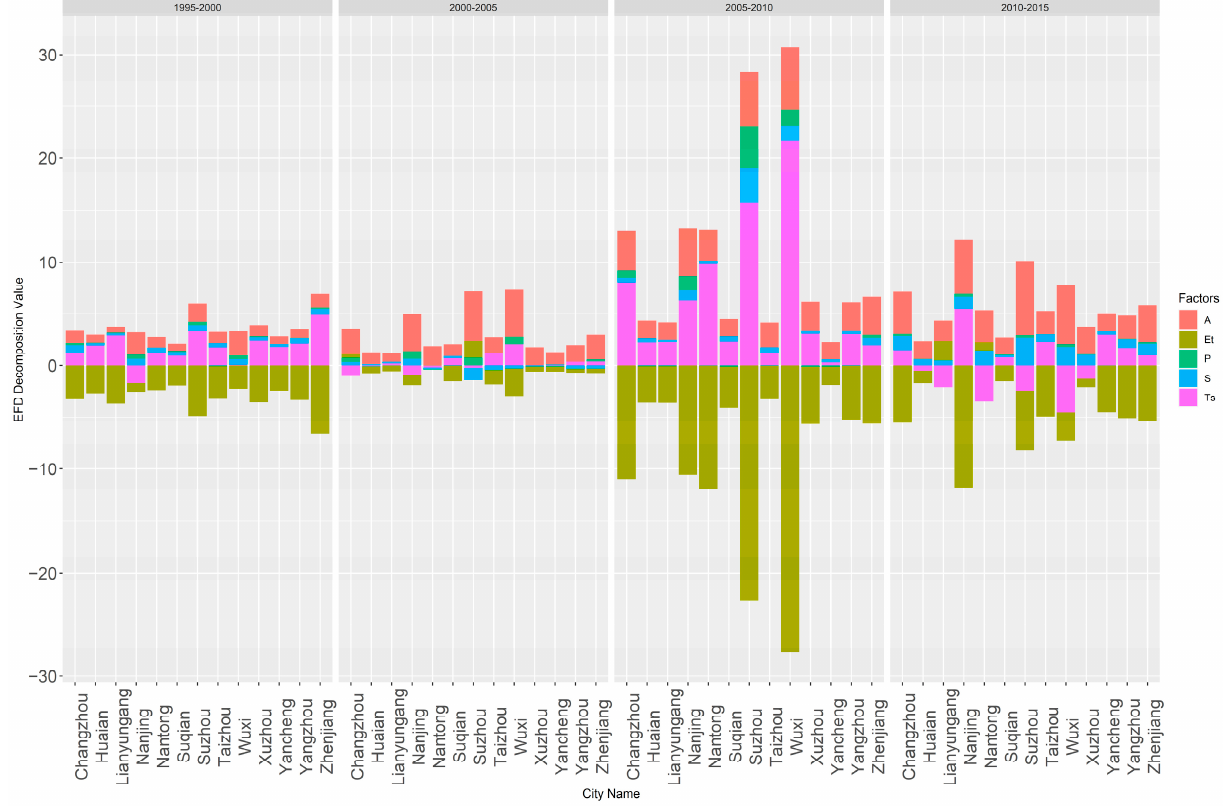
Figure 7. LMDI decomposition of Jiangsu’s prefecture-level cities of EFD changes in 1995–2015.